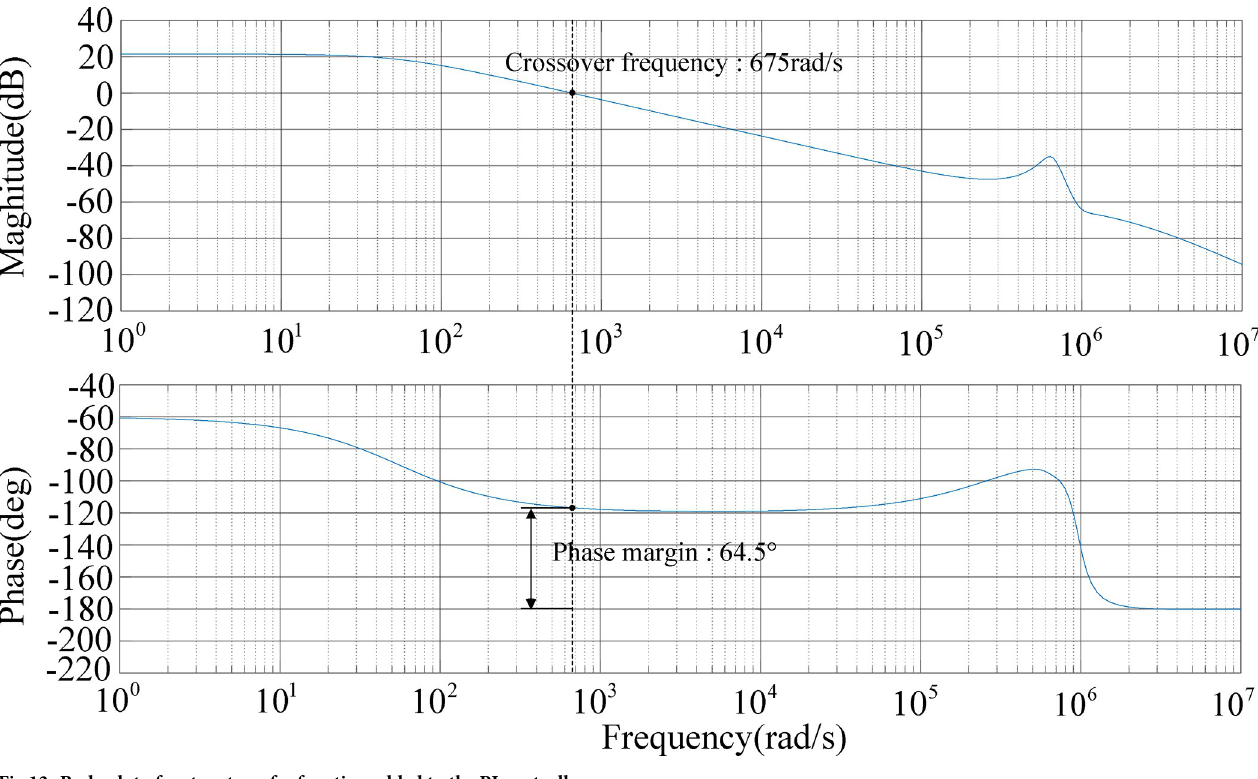
Fig 13. Bode plot of system transfer function added to the PI